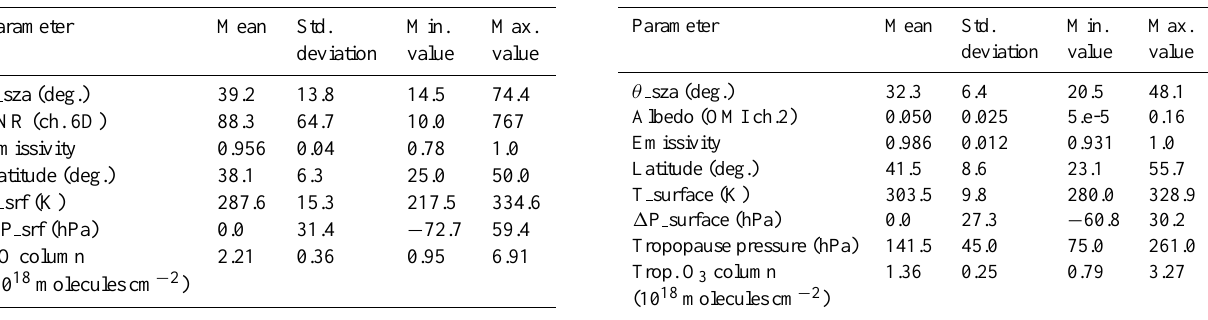
Table 2. Non-pressure-dependent parameters for TES-OMI O 3 AK multiple regression fit (August 2006 CONUS data, number of scenes in training